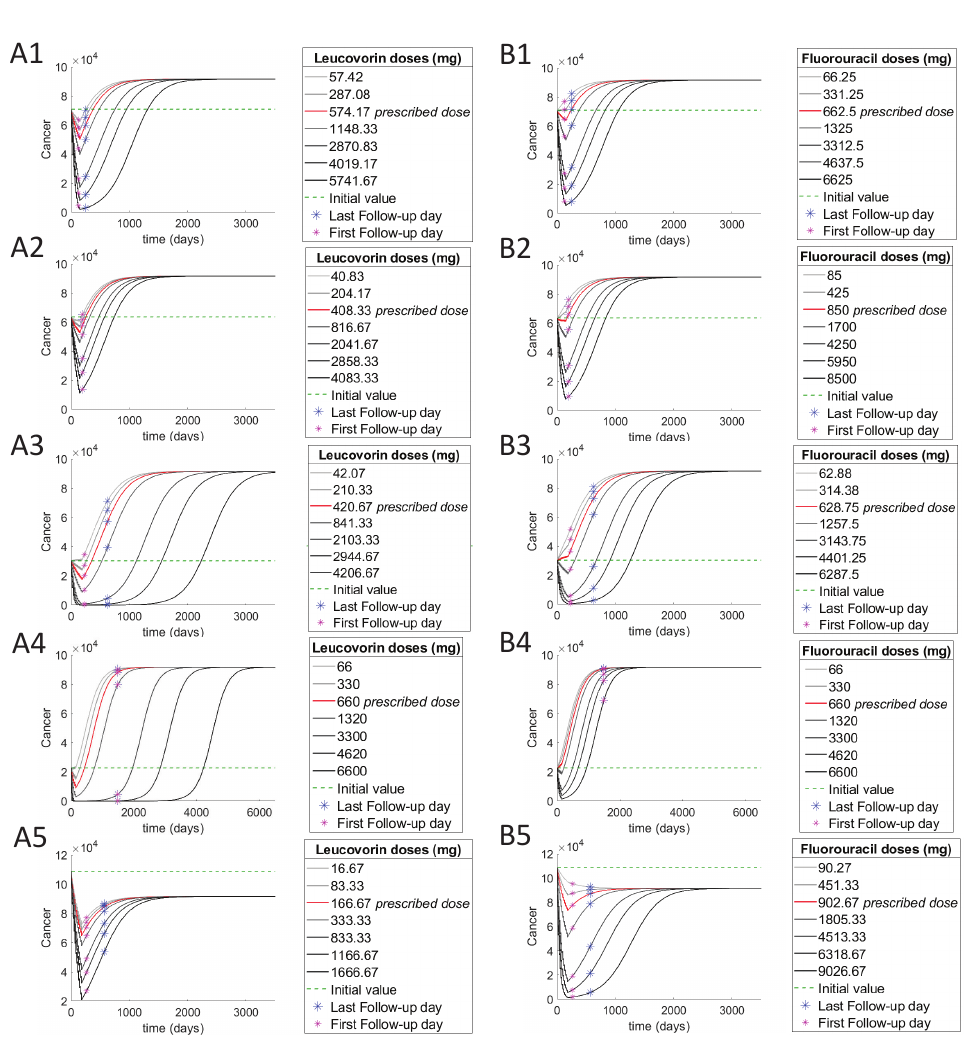
Figure 7. Cancer cells dynamics with varying doses for individual patients in each cluster. ( A ) are obtained by varying the Leucovorin dose while keeping the 5-FU dose constant. ( B ) are obtained by varying 5-FU and keeping the Leucovorin dose at zero. ( A1 , B1 ), ( A2 , B2 ), ( A3 , B3 ), and ( A5 , B5 ) respectively show the results of a tumor-free patient in the clusters 1, 2, 3 and 5. Note, the patient in cluster 3 ( A3 , B3 ) is tumor-free at the first follow-up day, but is with-tumor at the last follow-up day. ( A4 , B4 ) show the results of a with-tumor patient in the cluster